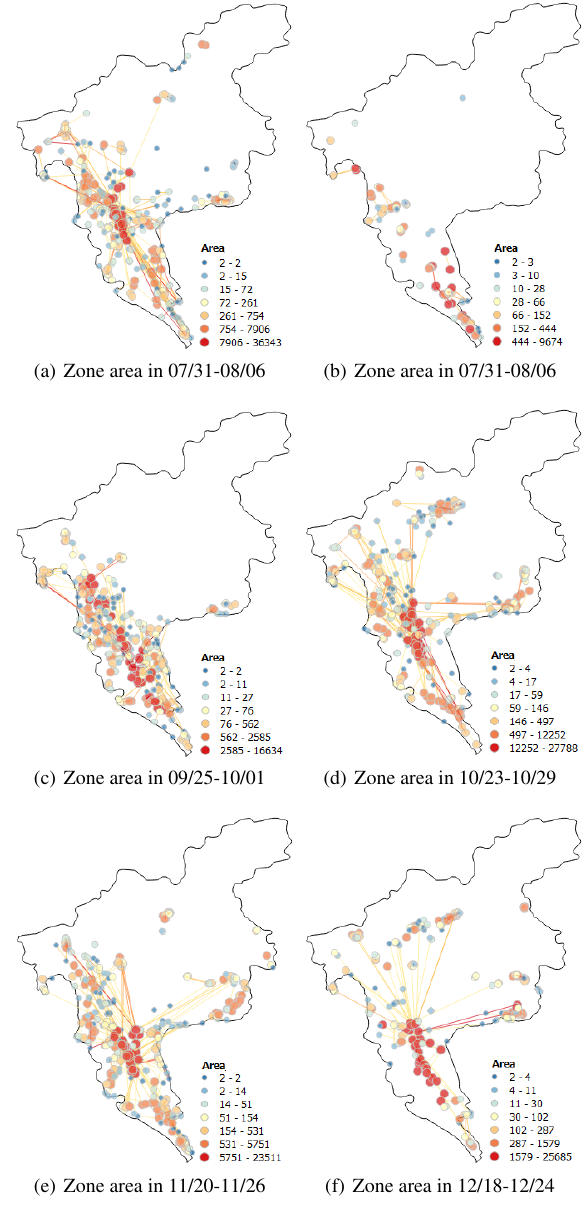
Figure 6. Trajectories of UHIs ( m = 3 ) for six weeks. Longer life-span of a UHI is presented in darker color.